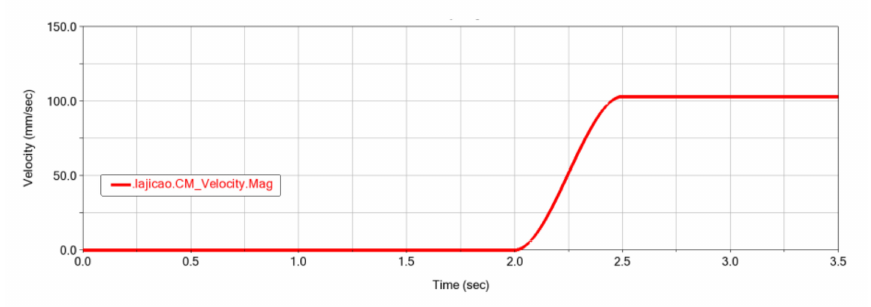
Figure 17. Flipping speed of the sorting mechanism.